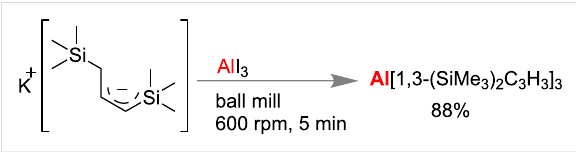
solution, but mechanochemically found to be a high yielding reaction when bulky 1,3-bis(trimethylsilyl)allyl anion (Scheme 48) was reacted with aluminum iodide